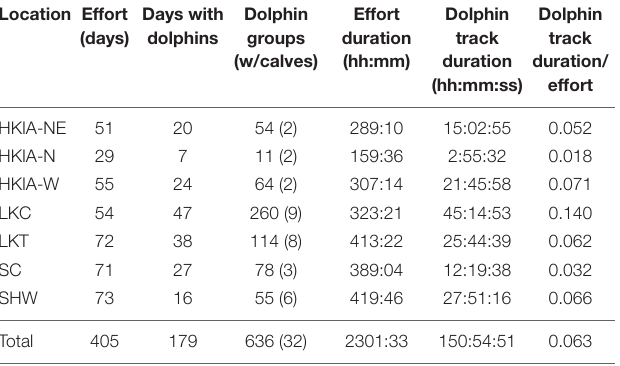
TABLE 3 | Survey effort and Indo-Pacific humpback dolphin track duration. Location Effort Days with Dolphin (days) dolphins groups